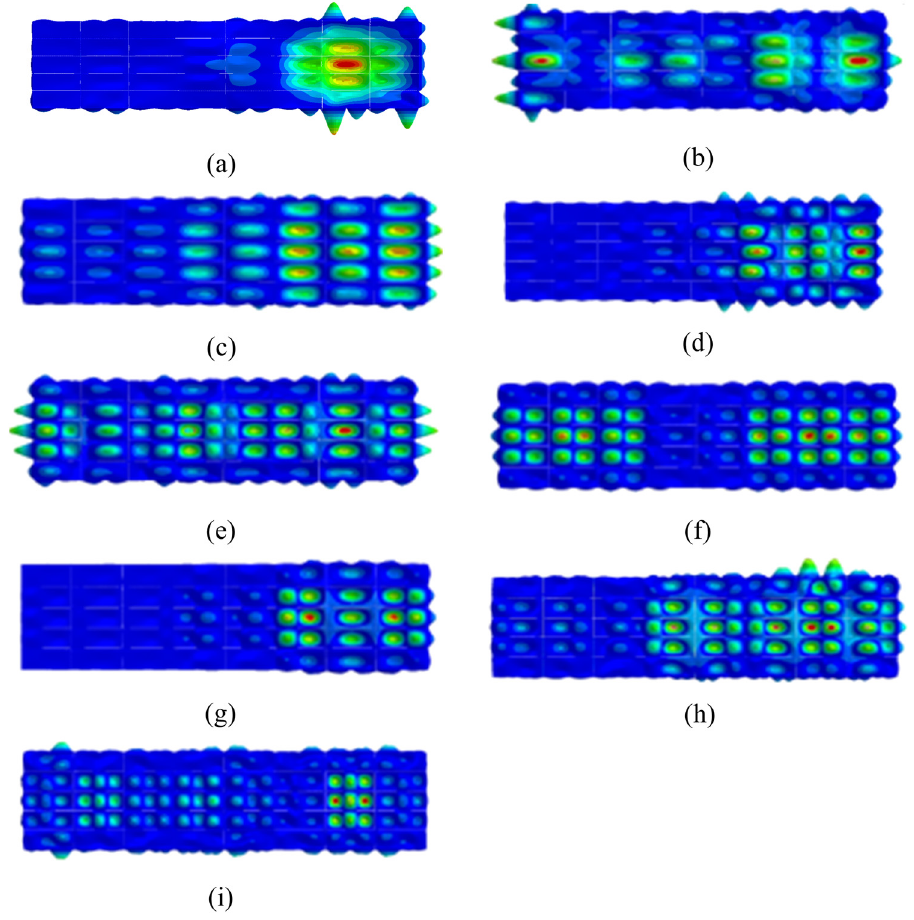
Figure 6: Modal results of multicompartment truss: ( a ) 60.9 Hz, ( b ) 90.8 Hz, ( c ) 110.1 Hz, ( d ) 126.7 Hz, ( e ) 131.1 Hz, ( f ) 140.7 Hz, ( g ) 145.3 Hz, ( h ) 158.6 Hz, and ( i ) 189.4 Hz.